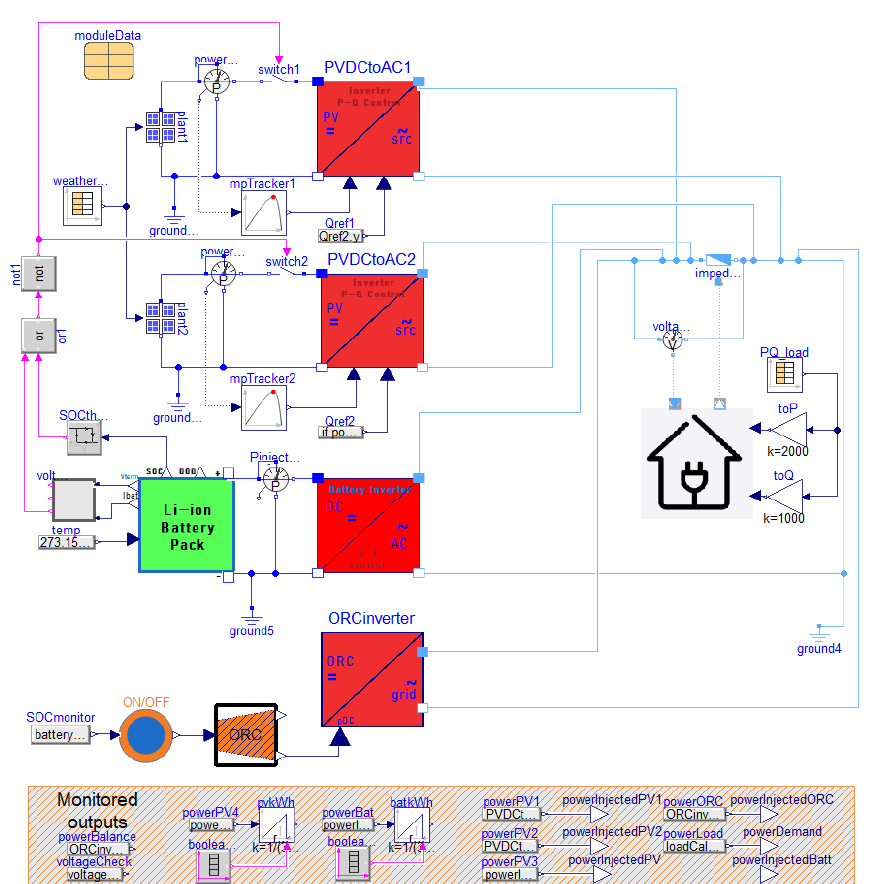
Figure 11. Local electrical grid model connected with the ORC system, powered by solar thermal energy and biomass.